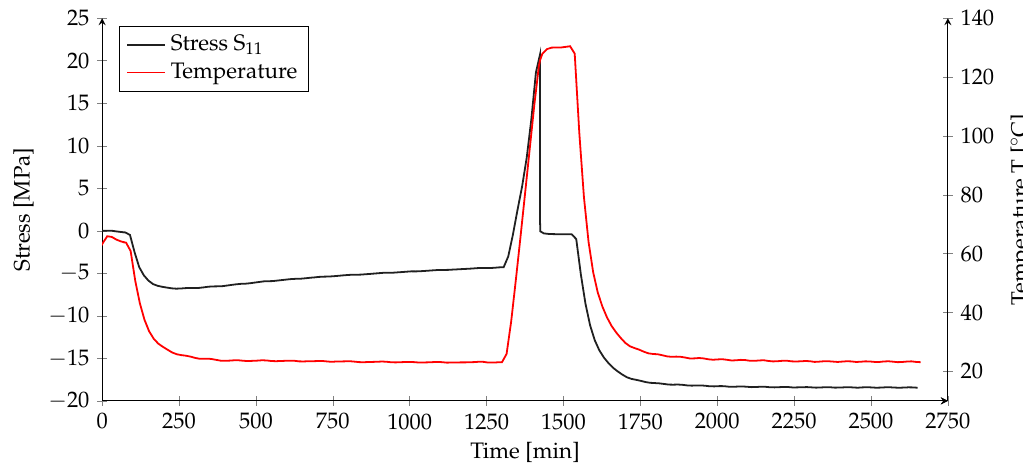
Figure 14. Stress development in fiber direction during the curing of panel 3.